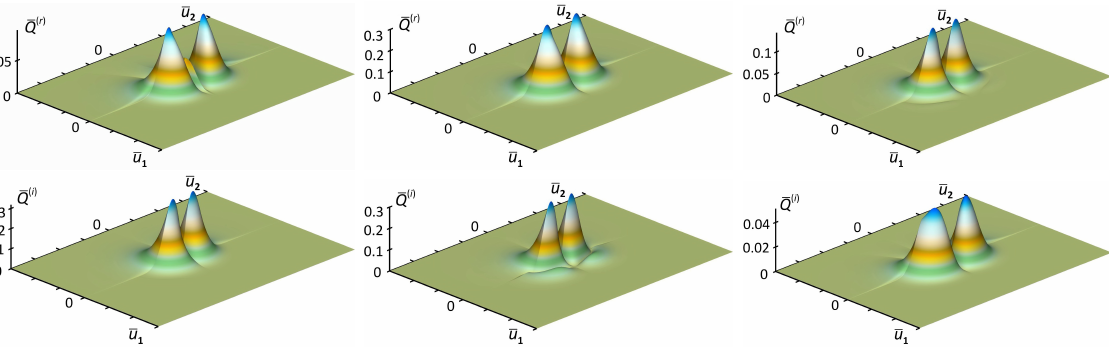
Figure 4. Distributions of the environment fields in the process of evolution, respectively, at the time points t 1 = 1.5, t 2 = 10 and t 3 = 20, calculated from the data of the first line table.